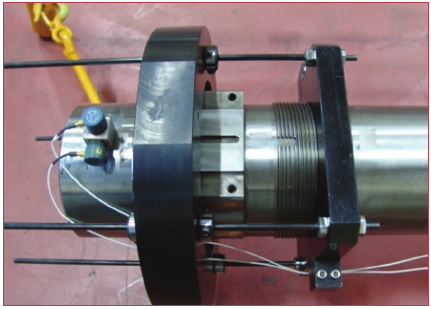
Figure 12: TMD installed at tip of beam.